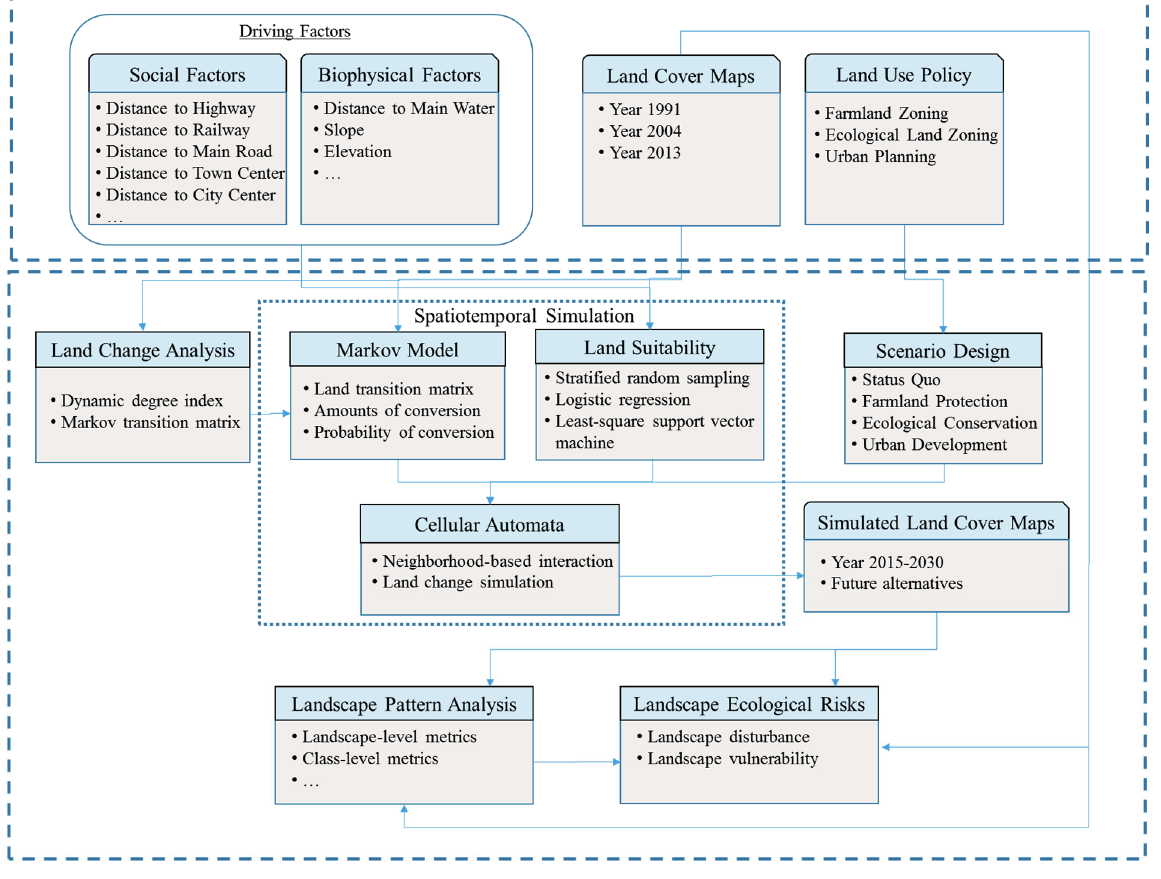
Figure 3. Spatially explicit modeling framework of land use and land cover change and associated landscape ecological